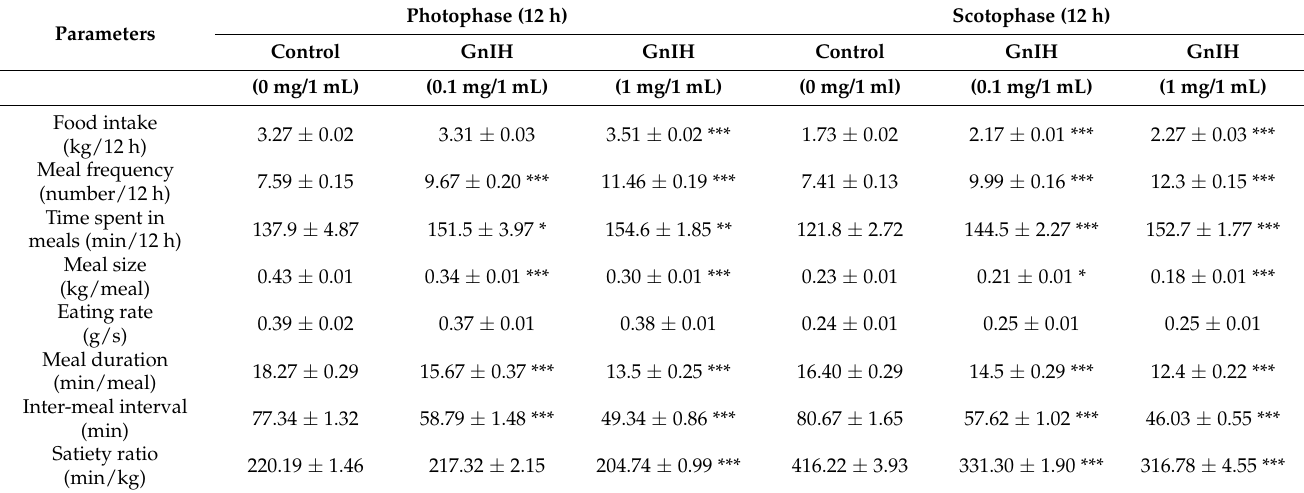
Table 1. Effect of GnIH injected intraperitoneally on meal microstructure in the ad libitum-fed